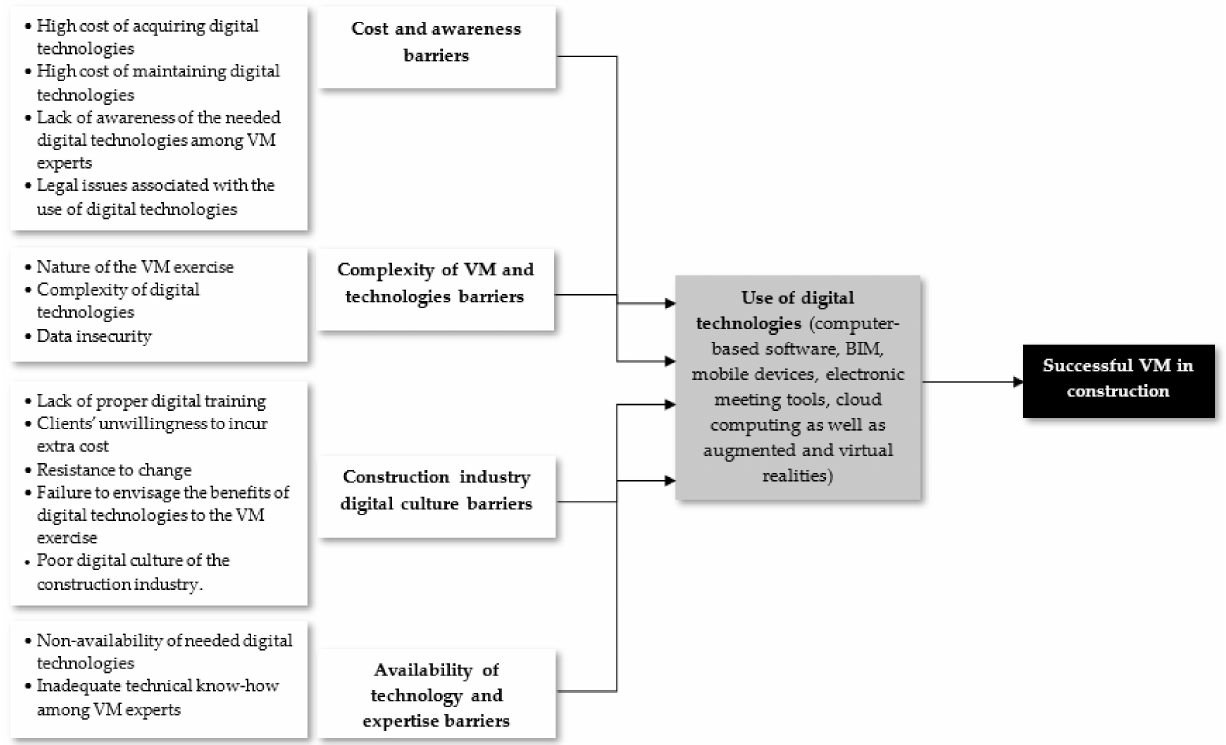
Figure 2. Summary of the barriers to the use of digital technologies for